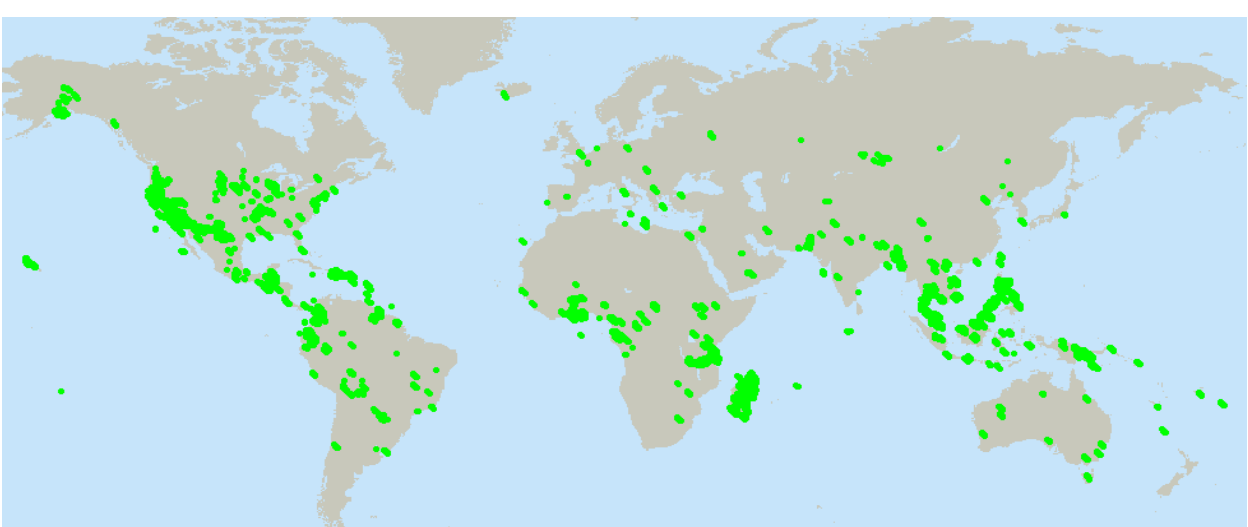
Figure 1. Plant Collection Locations (>60,000 data